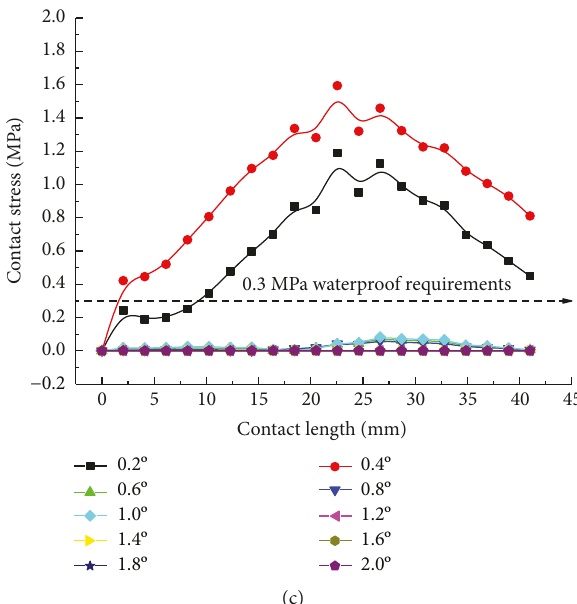
Figure 20: Contact stress curve of the second rubber ring after optimizing during clockwise rotation: (a) contact pressure of line 1 for the second rubber ring, (b) contact pressure of line 2 for the second rubber ring, and (c) contact pressure of line 3 for the second rubber